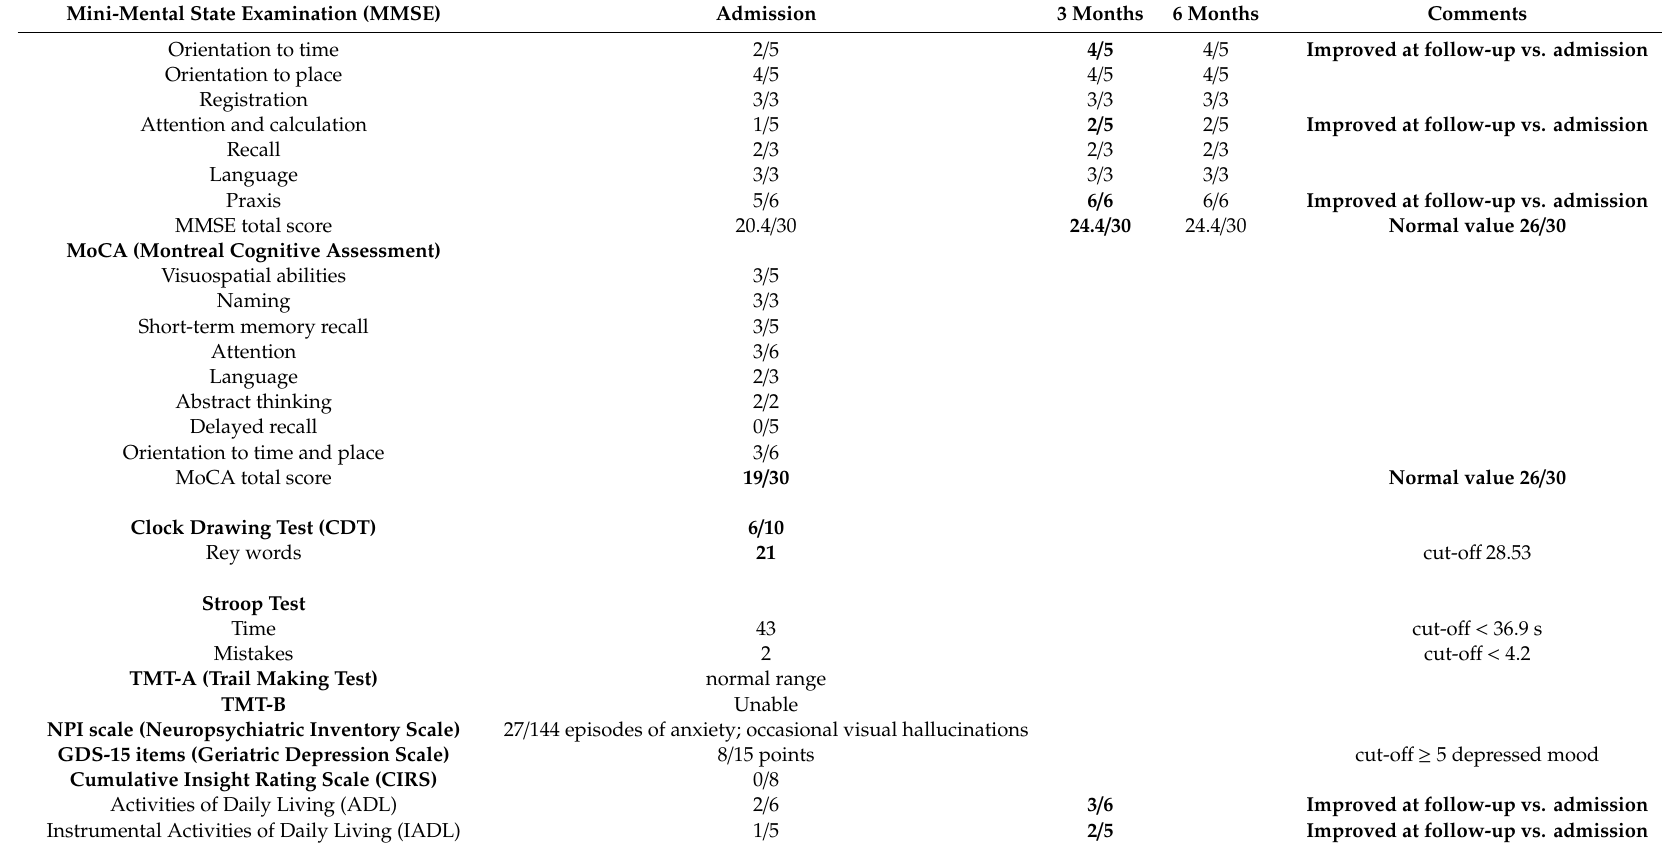
Table 3. Neuropsychological tests performed on our patient during the